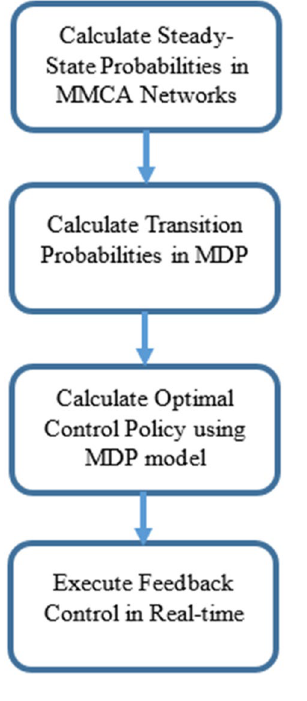
Fig. 4 Implementation strategy for multi-layered